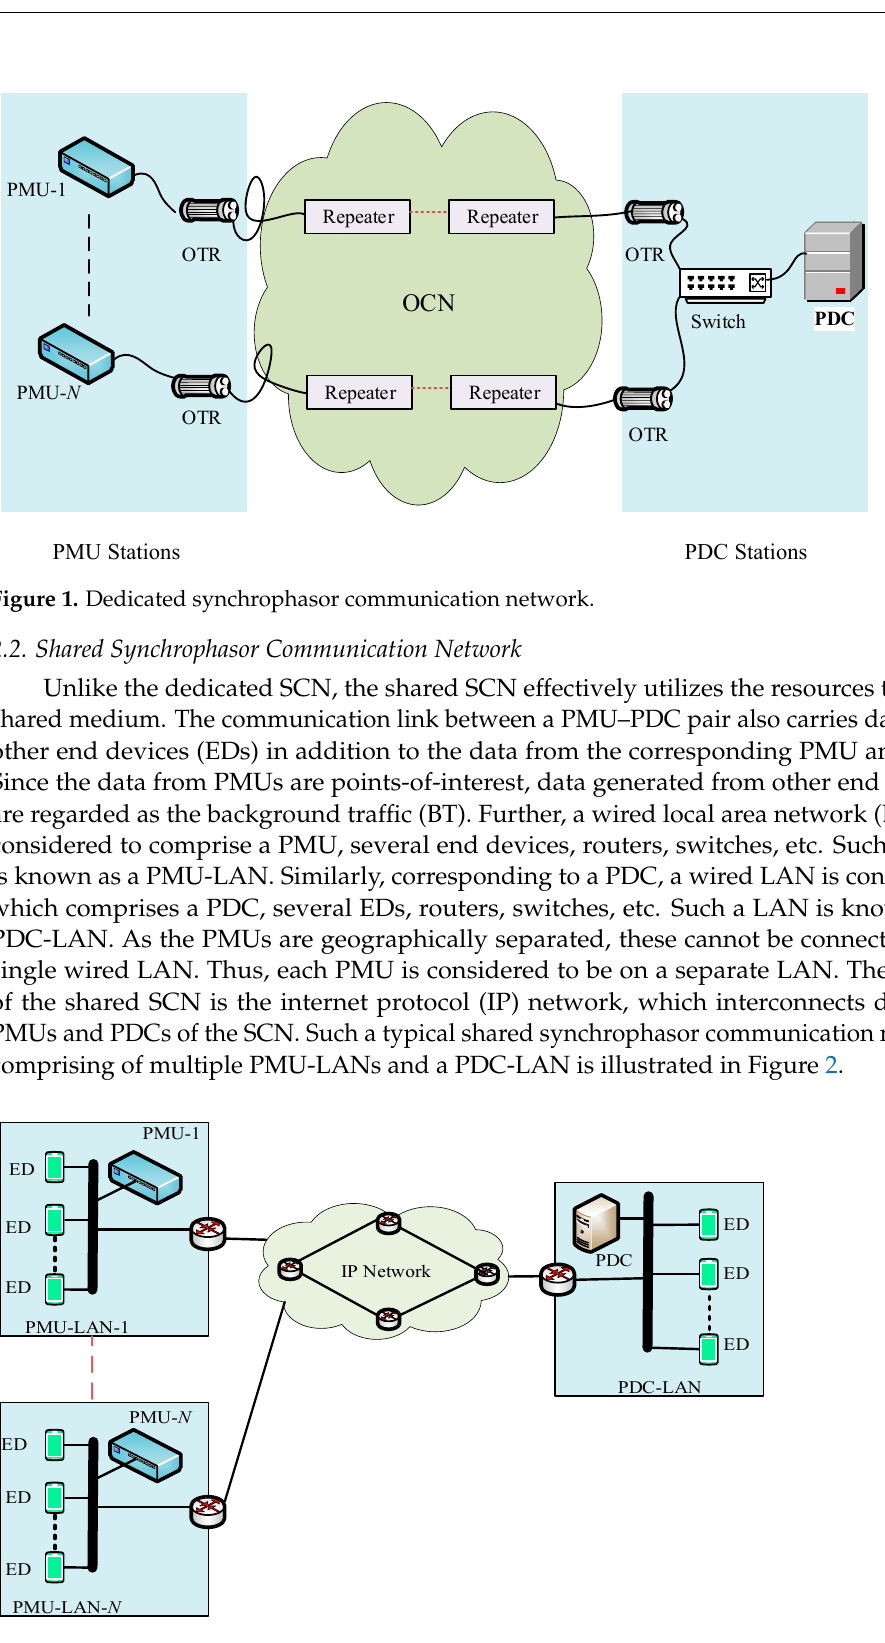
Figure 2. Shared synchrophasor communication network.